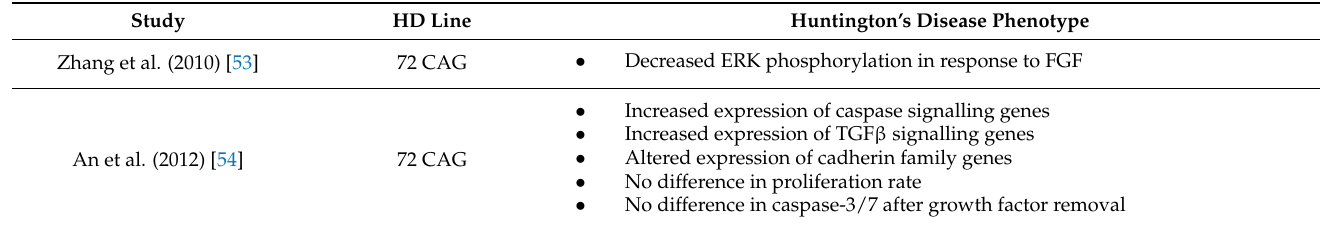
Table 3. Phenotypes observed in Huntington’s disease induced pluripotent stem